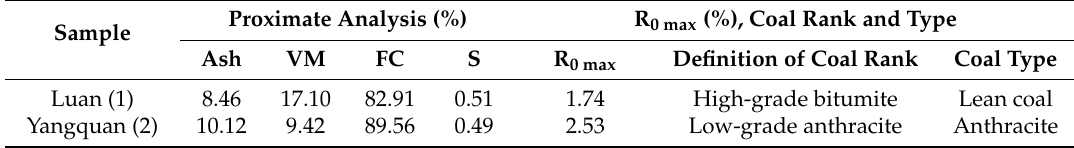
Table 1. Results of proximate analyses performed on different coal sample ranks.